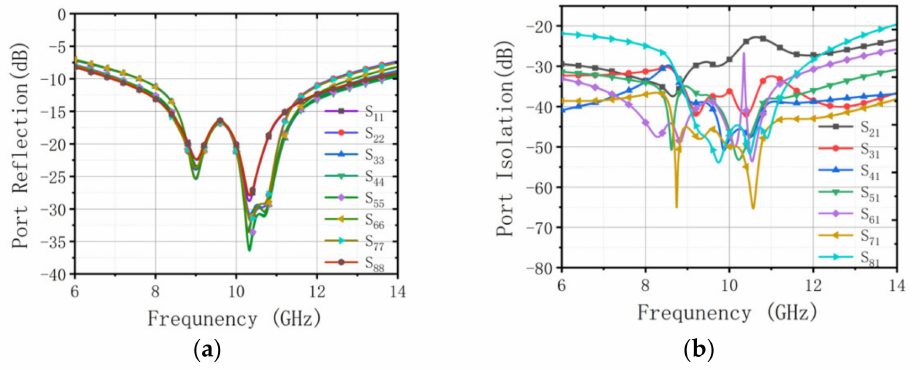
Figure 5. Schematic diagram of the broadband digital phased array structure.